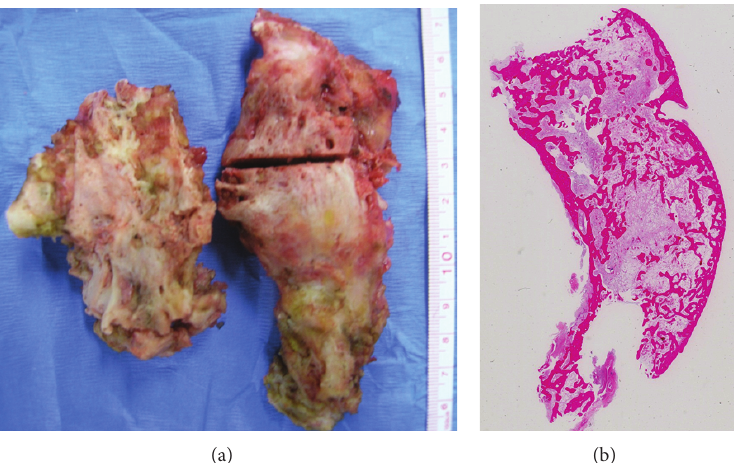
Figure 4: (a) Intra-articular giant ossified masses (12 × 4 and 8 × 4cm in size) were firmly adherent to the posterior and medial capsules and required special care to extirpate. (b) Hematoxylin-eosin staining of the ossified mass showing typical structures of mature